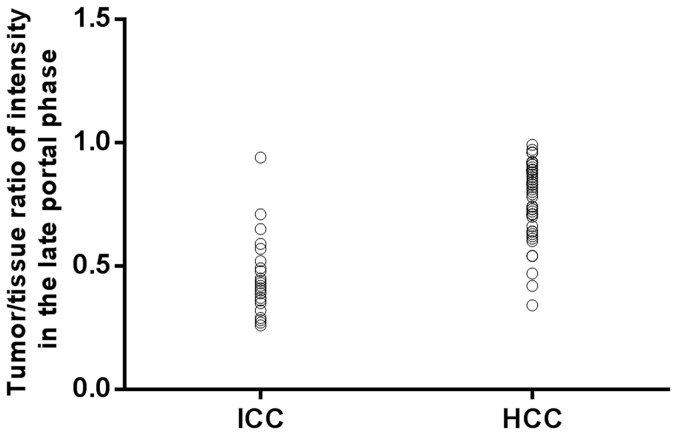
Frequency distribution of peak extent of washout in portal phase (Tumor/tissue ratio of intensity) in portal phase.The peak extent of washout is greater in patients with intrahepatic cholangiocellular carcinoma (ICC) than in those with hepatocellular carcinoma (HCC).